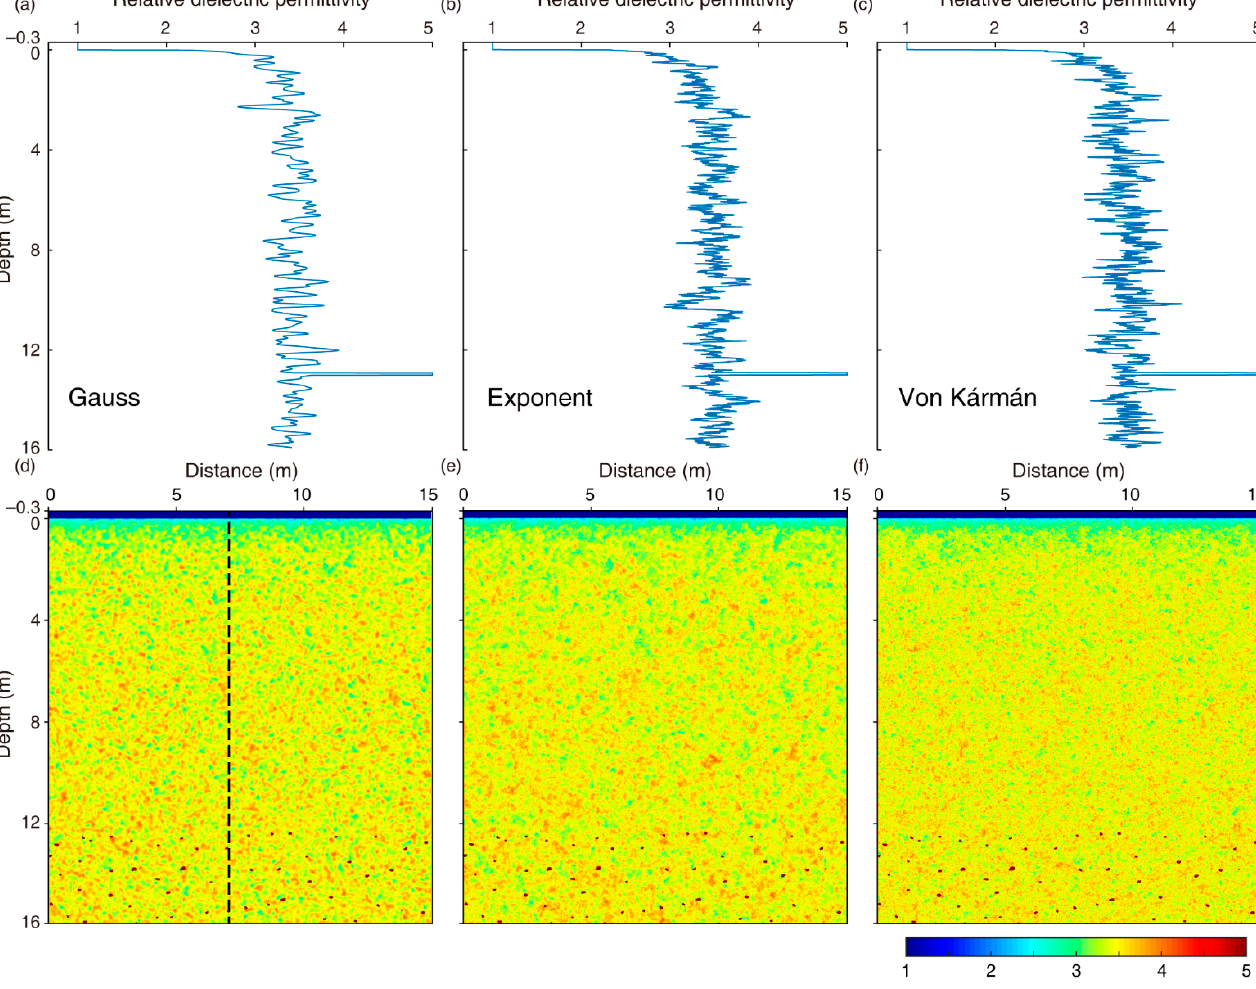
Figure 2. The Gaussian, exponential, and Von K á rm á n (zero-order) types of random media. ( a – c ) Fluctuation of the 1D probe along the center of the 2D model. ( d – f ) 2D relative dielectric permittivity models for three types of random media. The color bar represents the relative dielectric